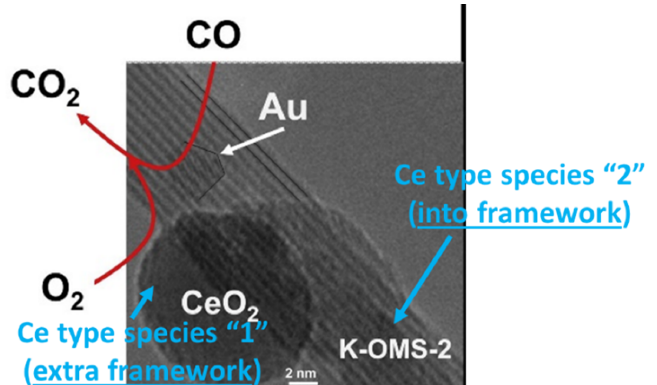
Figure 10 . HR-TEM micrograph of Au supported on [Ce]–K–OMS–2. In the image, different types of Ce species are indicated (blue color). Besides, the role of each chemical species is indicated for the CO oxidation reaction. The image has been extracted and modified from [174].